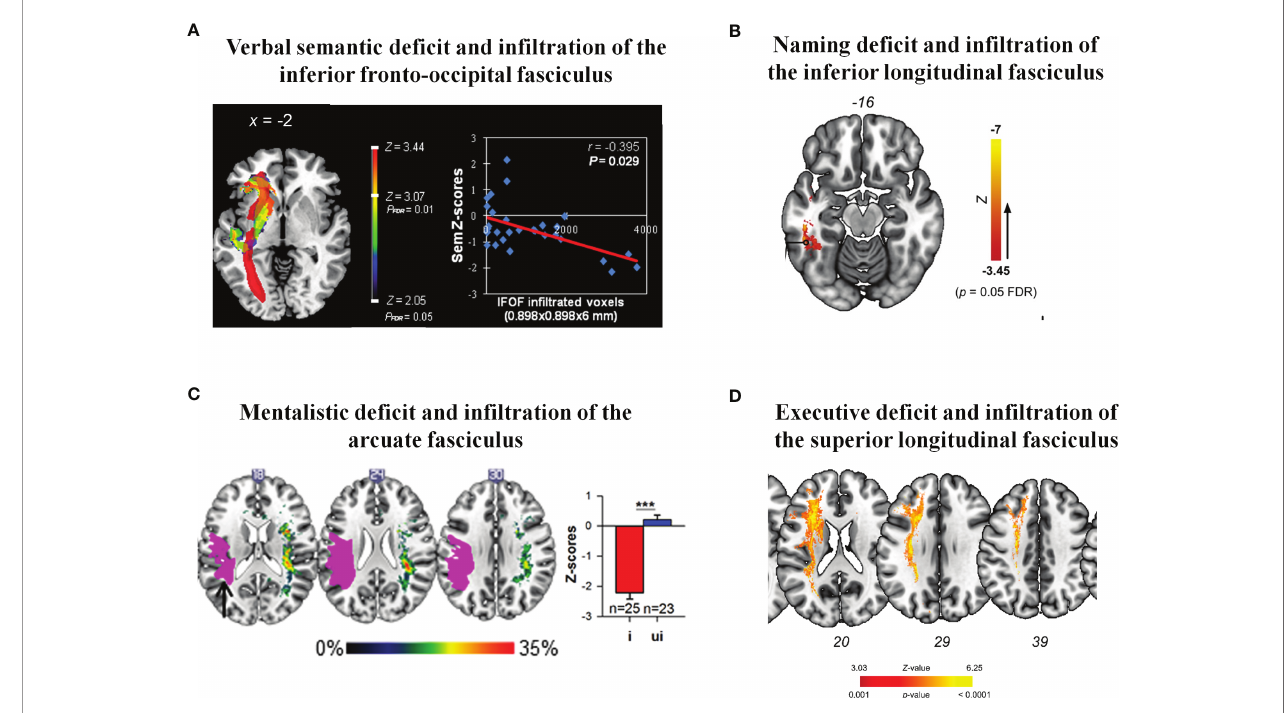
FIGURE 1 | Correlations between the degree of in fi ltration of WM tracts by the LGG and cognitive deteriorations: (A) Preoperative voxel-based lesion symptom map for semantic fl uency, evidencing signi fi cant relationship between the inferior fronto-occipital fasciculus in fi ltrated voxels by LGG and de fi cit of language semantics [from (78) with permission]; (B) Voxel-based lesion symptom of postsurgical lasting anomia performed on residual in fi ltration map, showing correlations between postoperative lexical retrieval troubles and LGG invasion of the left inferior longitudinal fasciculus [from (79) with permission]; (C) Signi fi cant relationship between postoperative residual tumor volume in the arcuate fasciculus and decreased low-level mentalizing accuracy [from (80) with permission]; (D) Disconnectome analysis demonstrating a signi fi cant link between postoperative persistent de fi cit of executive functions and the residual LGG in fi ltration volume in the superior longitudinal fasciculus [from (81) with permission]. ***Statistically signi fi